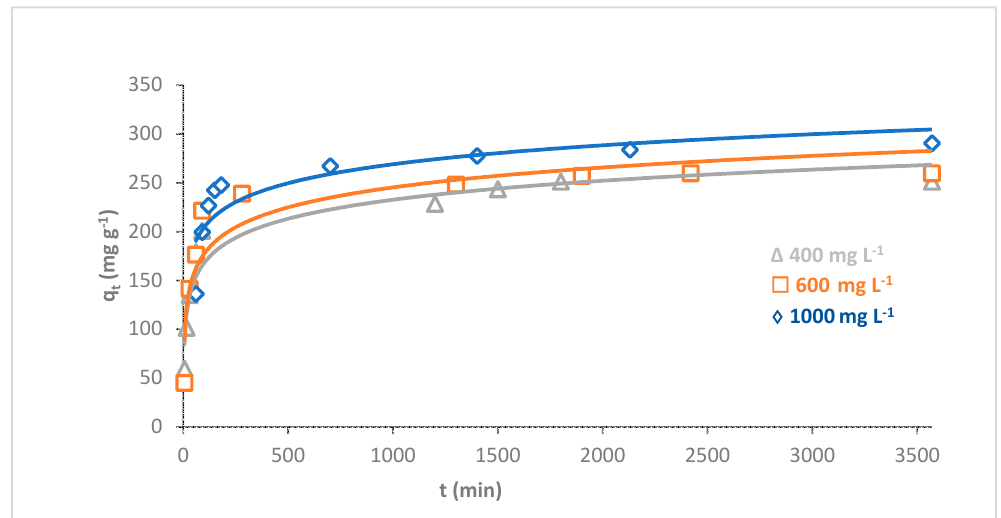
Figure 8. Effect of initial dye concentration on adsorption of MB dye onto O -CM-chitosan hydrogel at different time intervals (adsorbent dose 0.05 g, at 25 °C, pH 7 and 50 mL of dye solution with concentration from 400–1000 mg L − 1 ).